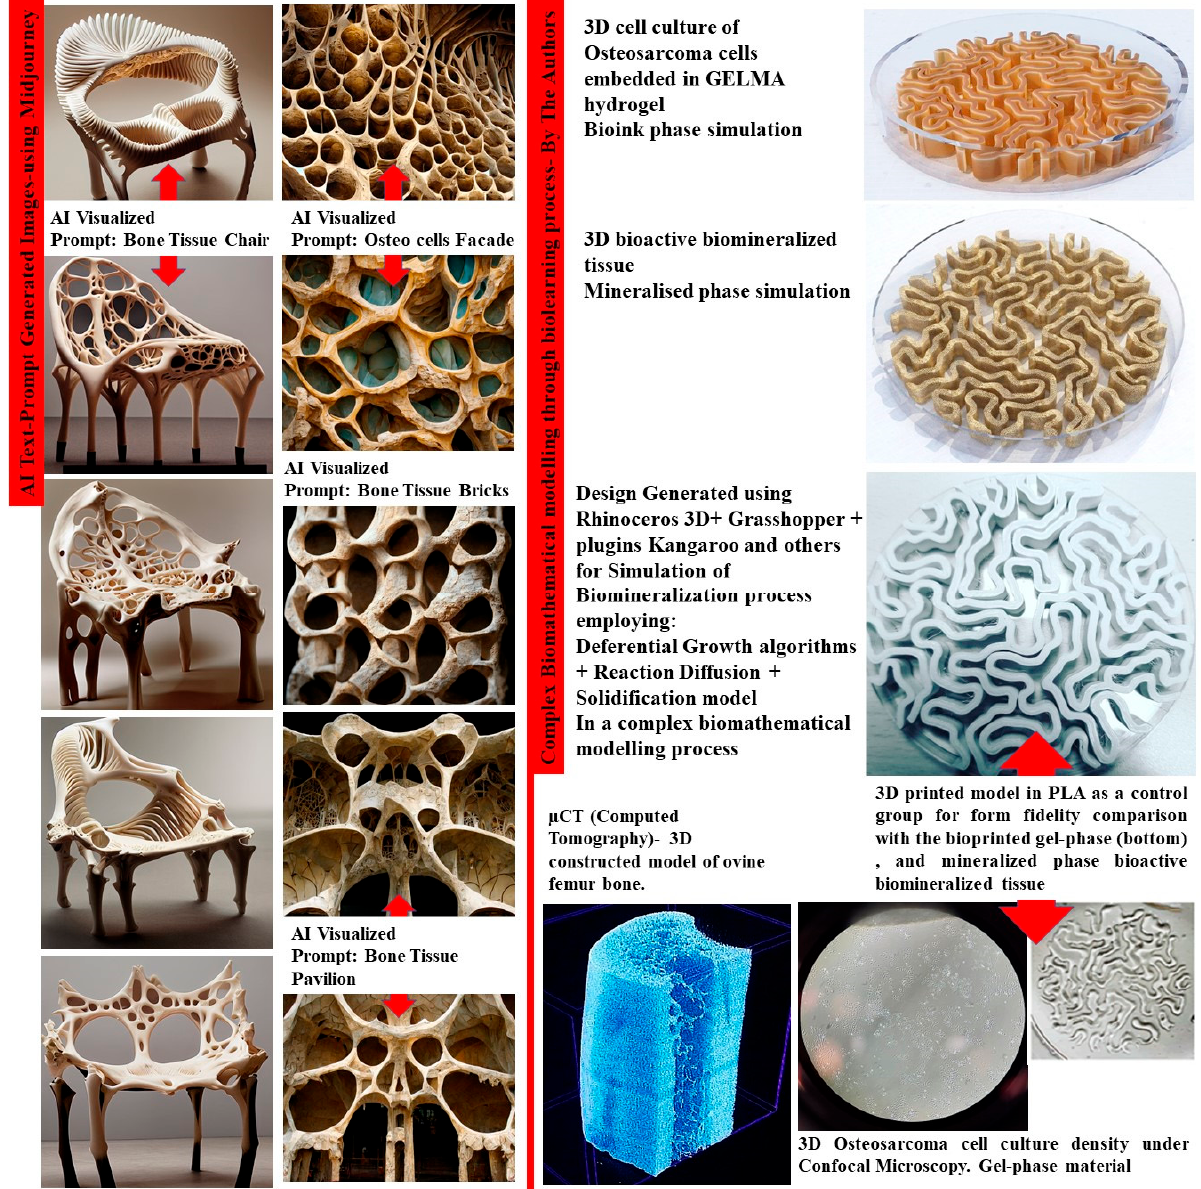
Figure 1. The bone chair biomineralization research project: Comparison of the biomaterials research-driven design process between biolearning biomathematical modeling by the authors and the biomimetic approach using AI text-prompt-generated images.